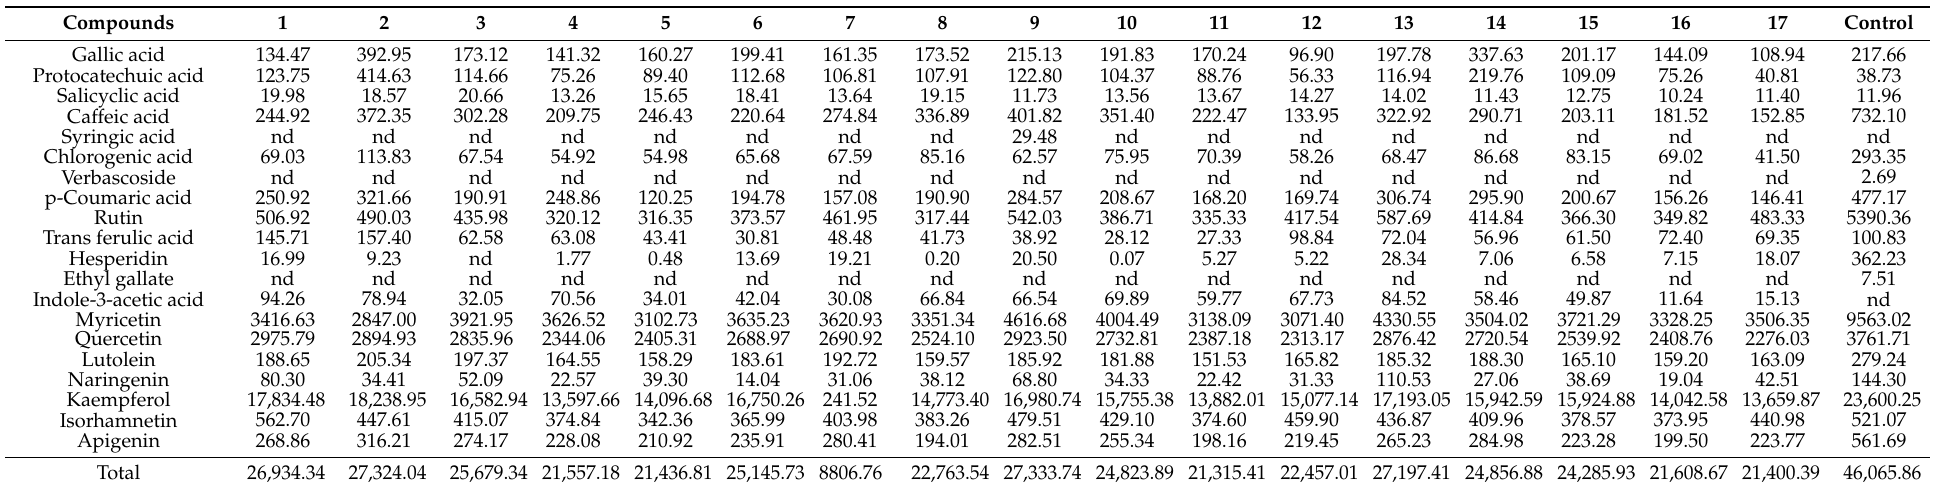
Table 6. Phenolic profile of bee pollen extracts ( µ g/100